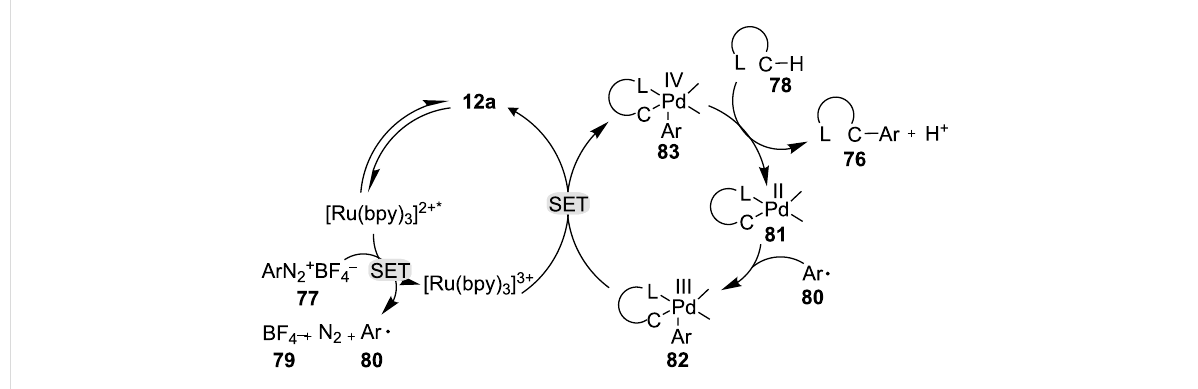
Figure 13: Proposed mechanism for C–H arylations in the presence of 12a and a Pd catalyst.